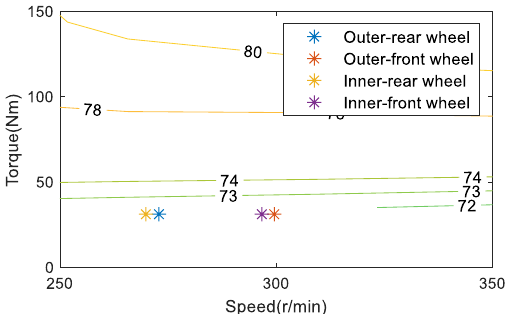
Figure 6. Working point of equal torque distribution at 30 km/h.